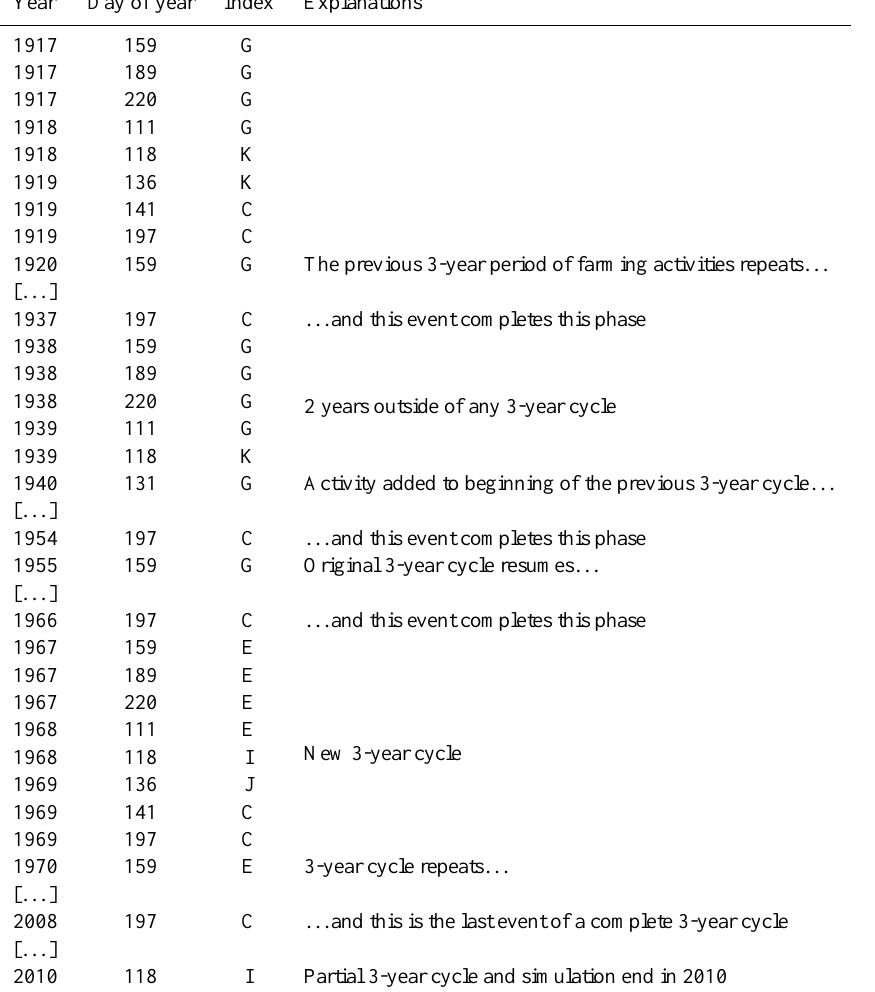
Table 3. Example cultivation schedule for Dunn County, North Dakota. Farming activities map by indices (column 3) to 30-day enhancement effects on soil decomposition (Table 2). Farming activities that occur before the 30 days have completed take full effect and replace previous activities. Farming activities do not